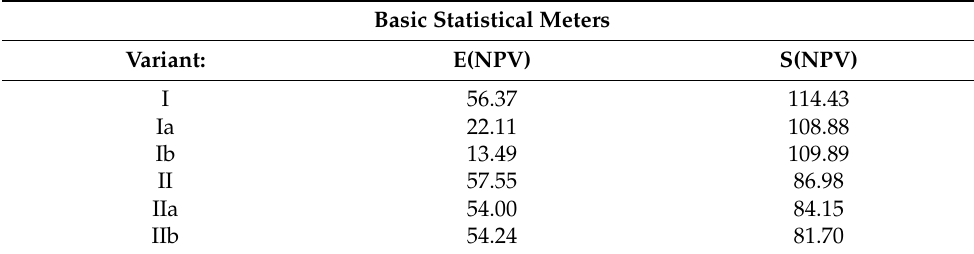
Table 6. Basic statistical meters for all analysed